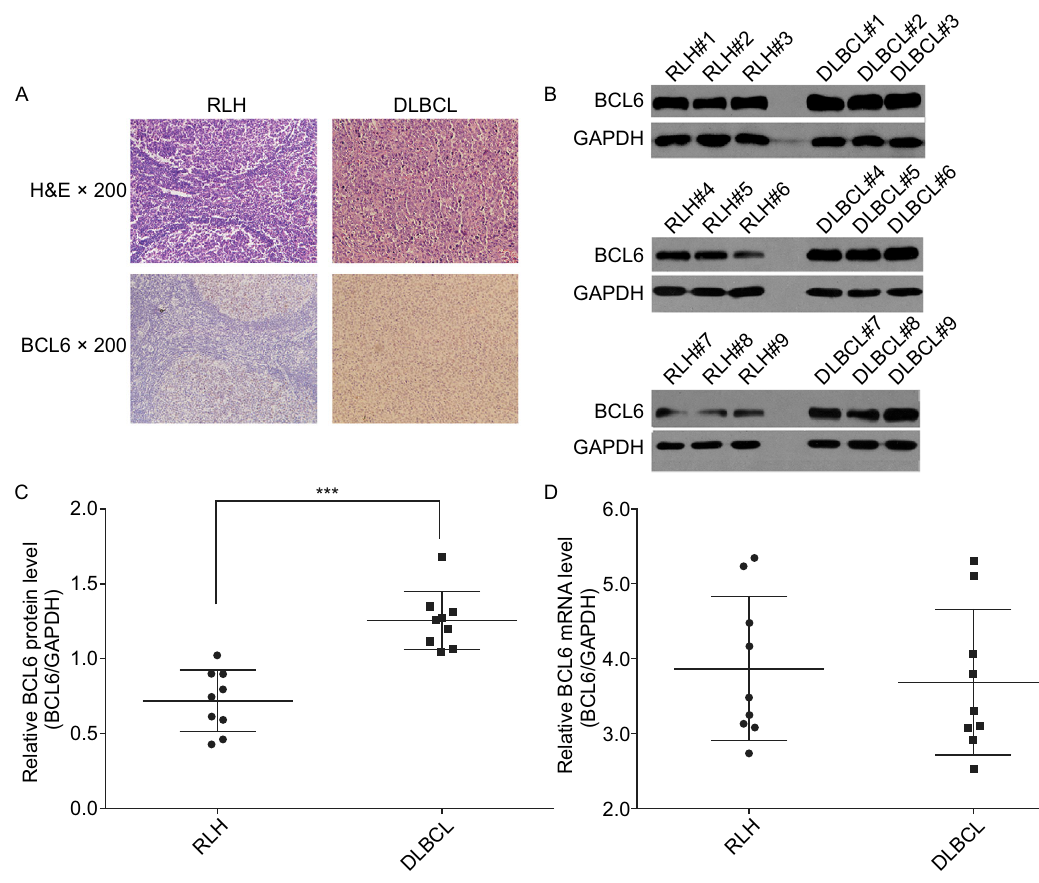
Figure 1. BCL6 protein and mRNA in human tissues. (A) Representative H & E-stained and BCL6-stained sections of the DLBCL & RLH tissues; Western blotting analysis of the expression levels of BCL6 protein in 9 cases of DLBCL and 9 cases of RLH. (B) Representative image. (C) Quantitative analysis; (D) Quantitative RT-PCR analysis of BCL6 mRNA levels in the same DLBCL and RLH tissues, the relative expression was assessed using Δ Ct values ( Δ Ct = Ct BCL6 − Ct GAPDH ). The GAPDH gene served as the endogenous control. Data (mean ± SEM) are representative of 3 technique replicates. *** P <